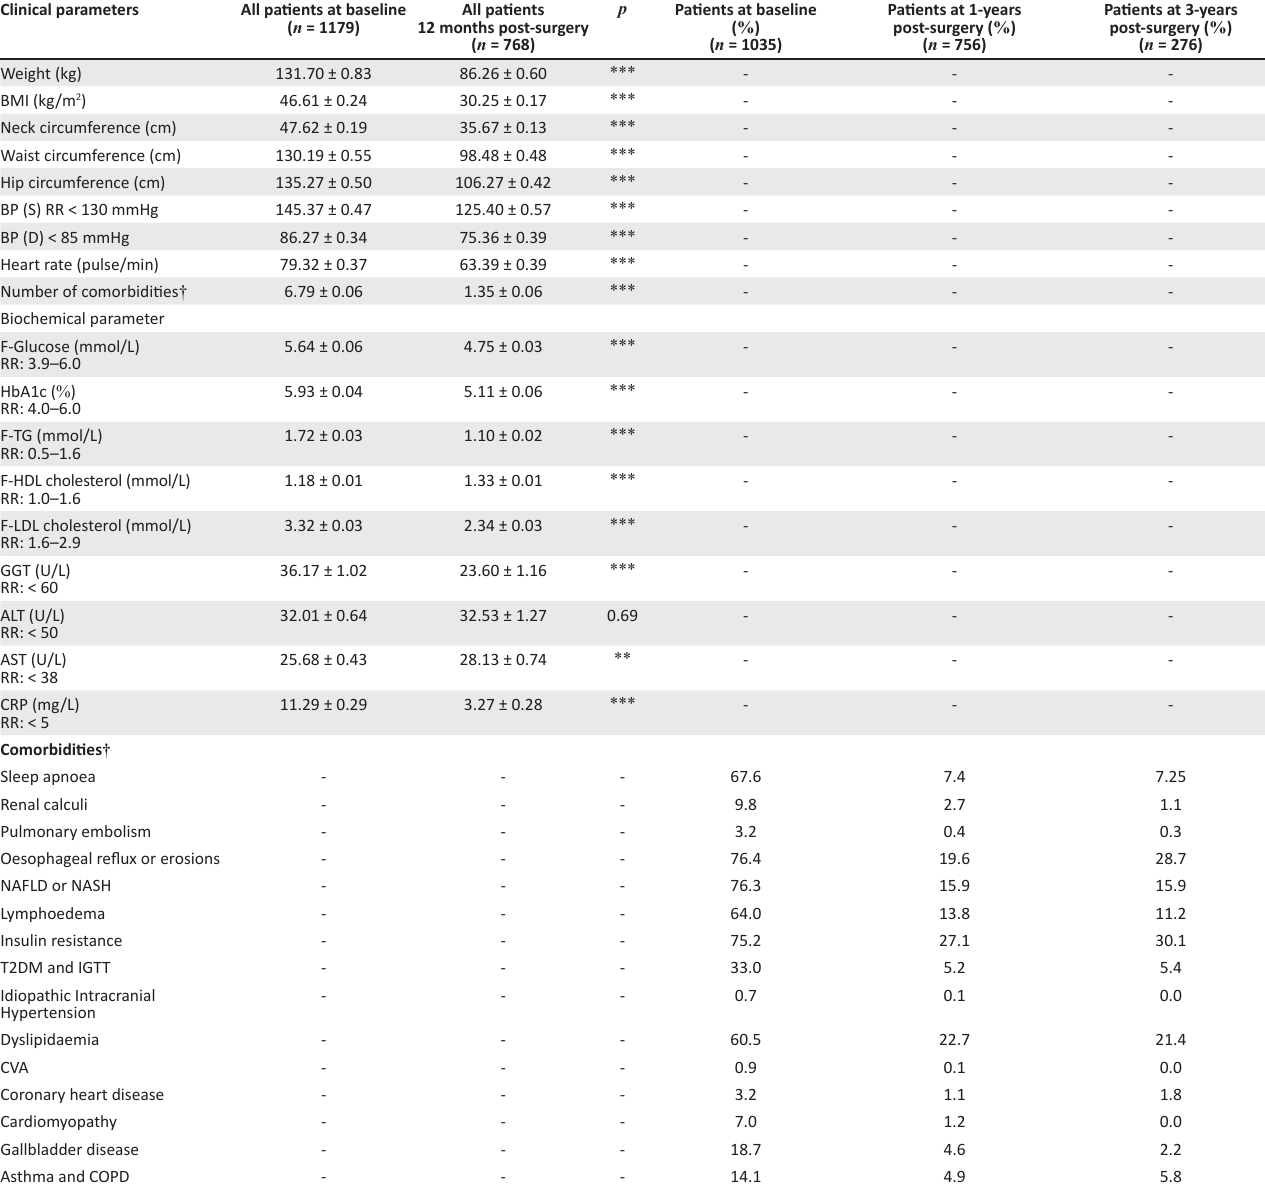
TABLE 1: Clinical and biochemical outcomes and remission of comorbidities for patients with obesity receiving bariatric surgery at baseline, 12-months and 3-years, respectively, after surgery. Clinical parameters All patients at baseline ( n = 1179)